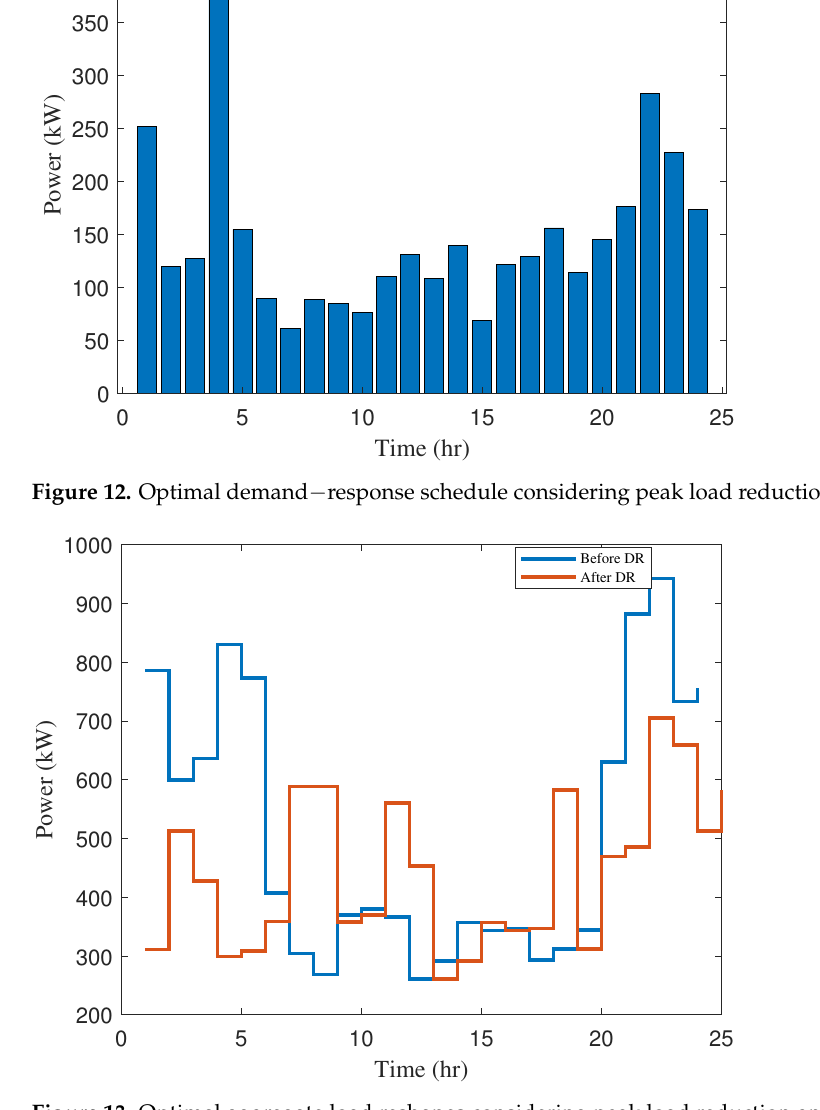
Figure 13. Optimal aggregate load reshapes considering peak load reduction and user